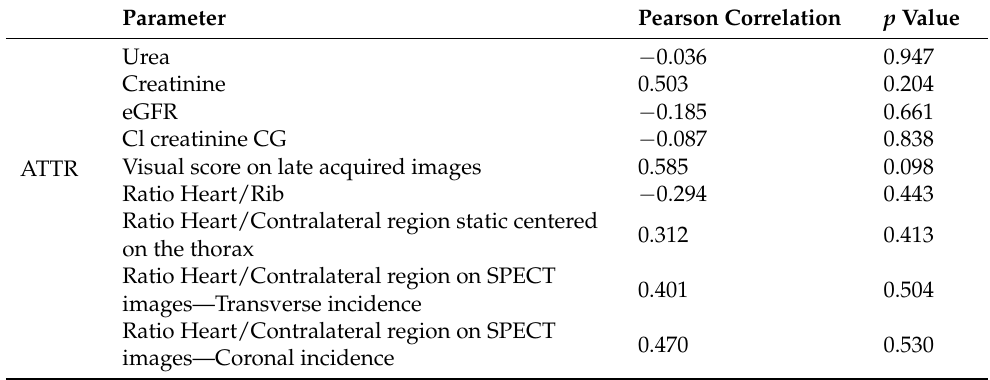
Table 9. Parameters correlation between bone scintigraphy parameters and renal function.